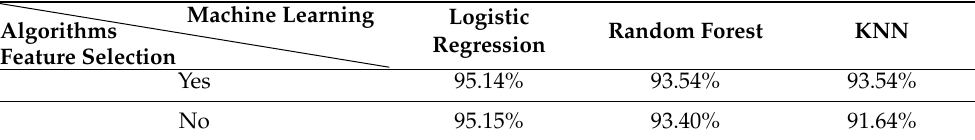
Figure 11. Confusion matrix of logistic regression algorithm.